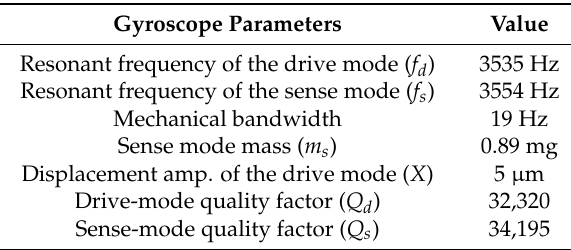
Table 1. Parameters of the gyroscope.